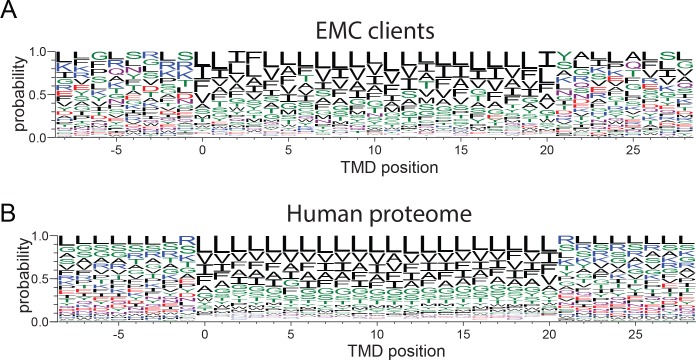
Amino acid composition of transmembrane domains of EMC clients and background.(A,B) Weblogos of amino acid frequencies at positions along transmembrane domains of EMC clients (A) and transmembrane domains in the total human proteome (B).